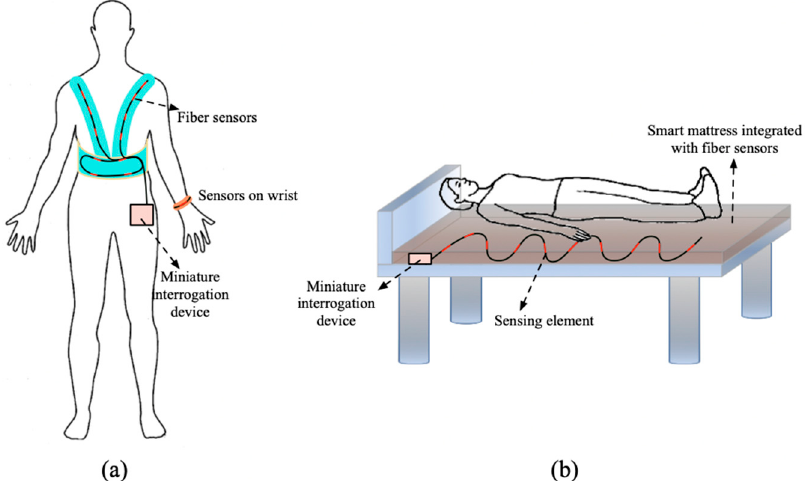
Figure 6. Schematic demonstrating health-care monitoring based on optical fiber sensors, where ( a ) shows sensor devices in a brace and a bracelet to monitor heart condition, blood pressure, and respiration, ( b ) illustrates a smart mattress integrated with optical fiber sensors to monitor health condition during sleeping, e.g., heart and respiration rates and the status of lying in bed or leaving the bed.